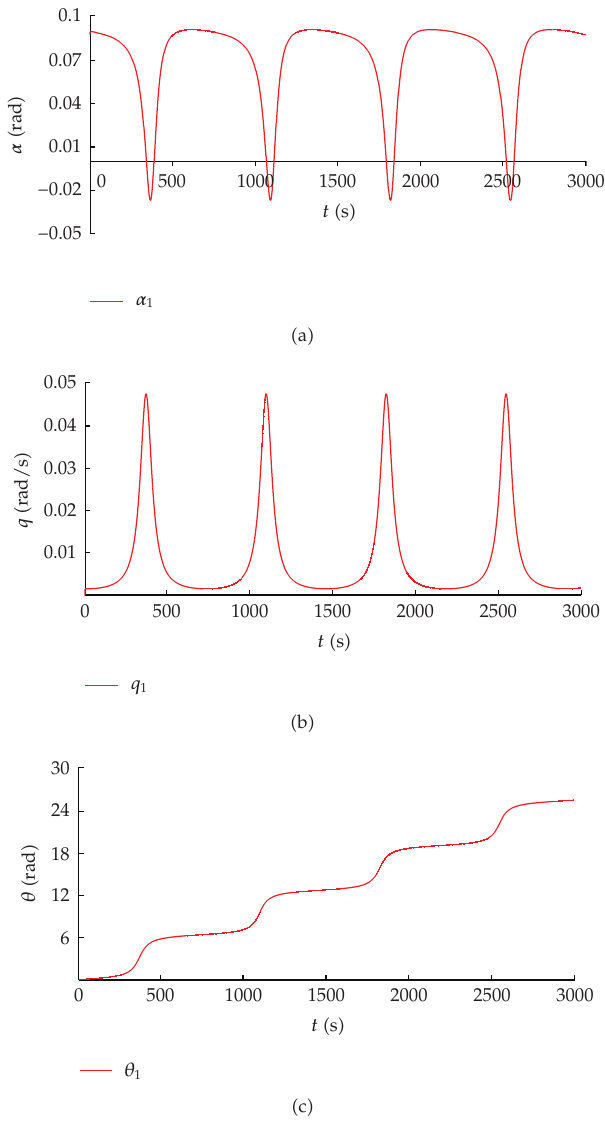
Figure 5: Oscillations when δ (cid:6) (cid:7) 0 . 0869742 (cid:5) rad (cid:6) (cid:7) 4 . 985 ◦ ; q (cid:6) point is α (cid:6) 1